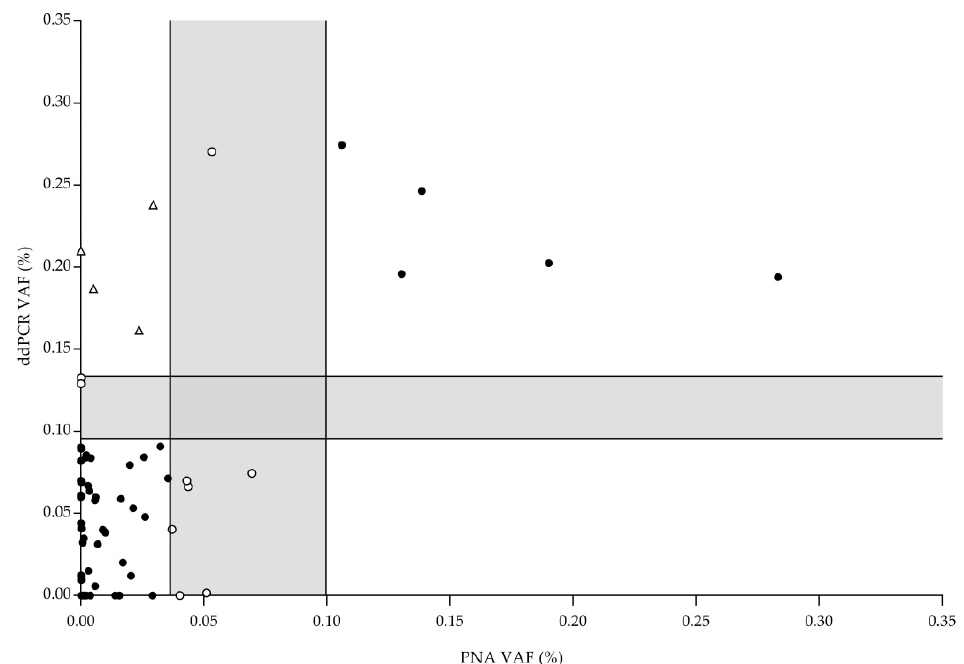
Figure 2. ddPCR and PNA Clamp TaqMan assays results for 78 FFPE specimens. Each symbol represents one sample whose position is determined by PNA Clamp TaqMan assay result ( X -axis) and ddPCR assay result ( Y -axis). Gray bars represent uncertainty zone of each methodology which is limited by LOB and LOD values. ( ● ) Samples with concordant results, ( ○ ) samples in uncertainty area and ( ∆ ) samples with discordant results. Positive samples with VAF higher than 0.3% are not depicted.